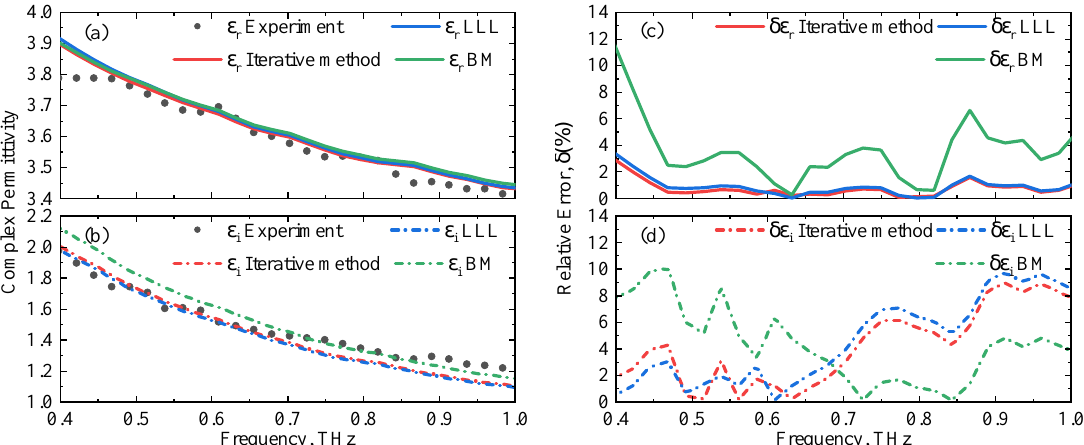
Figure 5. ( a , b ) Comparison of the experimental and estimated complex permittivity of gelatin-water-oil phantom (LLL—Landau-Lifshitz-Looyenga model, BM—BG model) ( c , d )The relative errors of the EMT models. Upper—real part of the complex permittivity. Lower—imaginary part of the complex